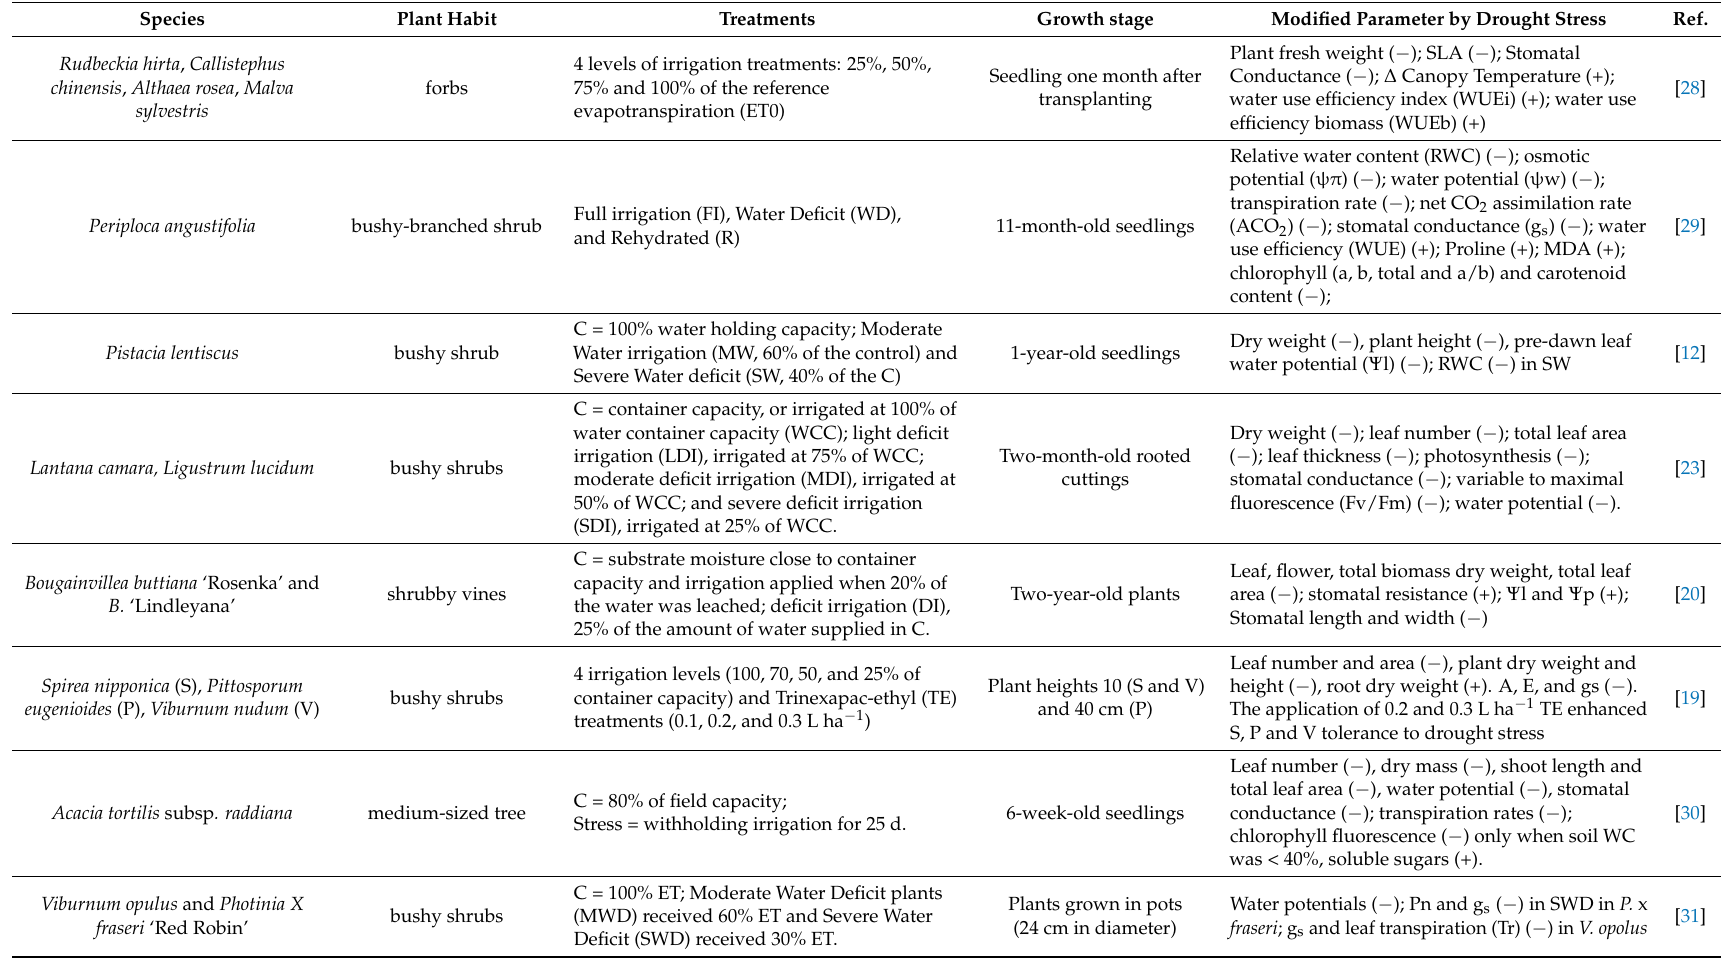
Table 1. Major effects of drought stress on ornamental plants 1